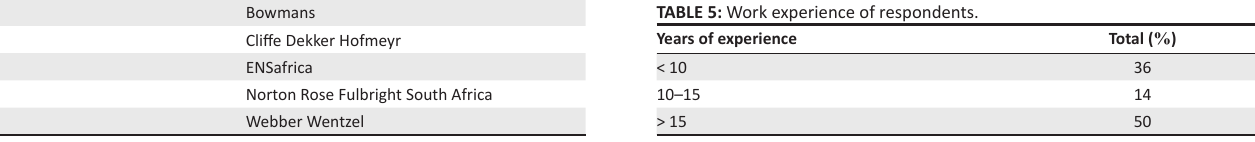
TABLE 3: The five legal firms, in alphabetical order, that were included in the sample. Number